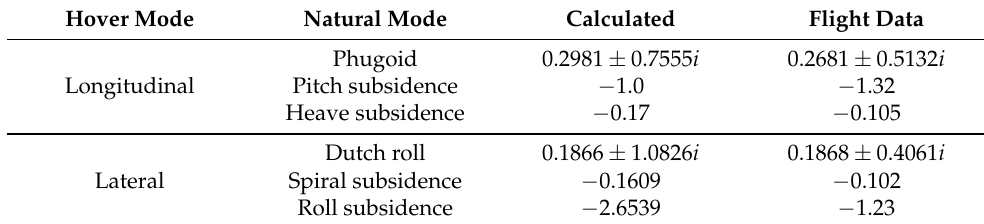
Table 2. Hover mode eigenvalue